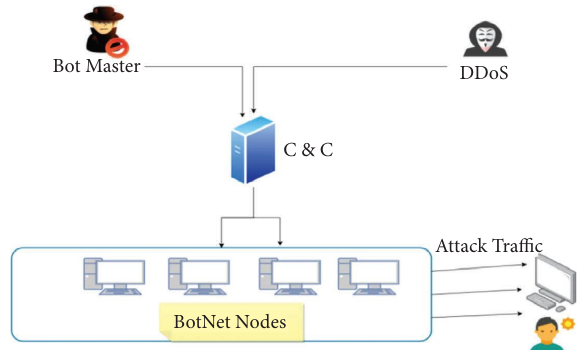
Figure 1: Generic structure of